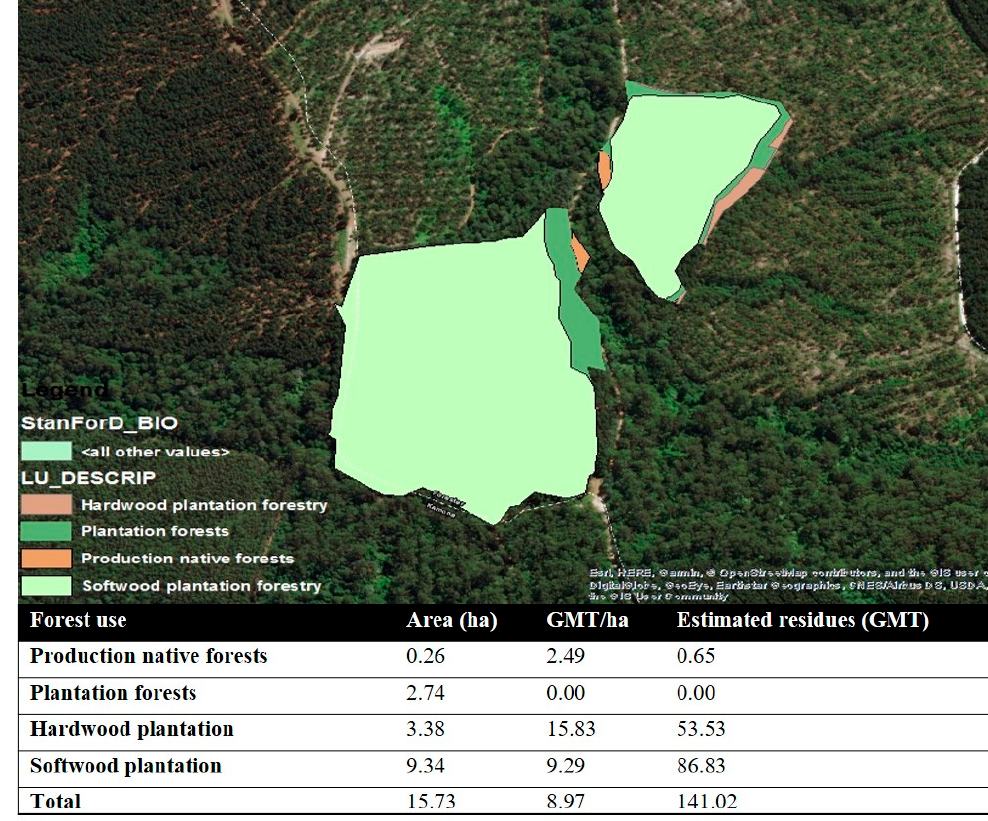
Figure 8. Estimated forest residue from PFT and STT residue models [3].